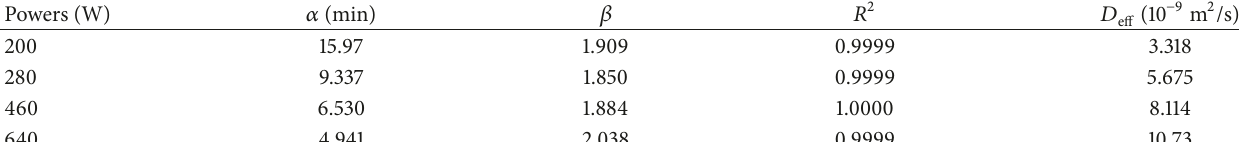
Table 1: Moisture effective diffusion coefficients of GB seeds by different microwave powers.